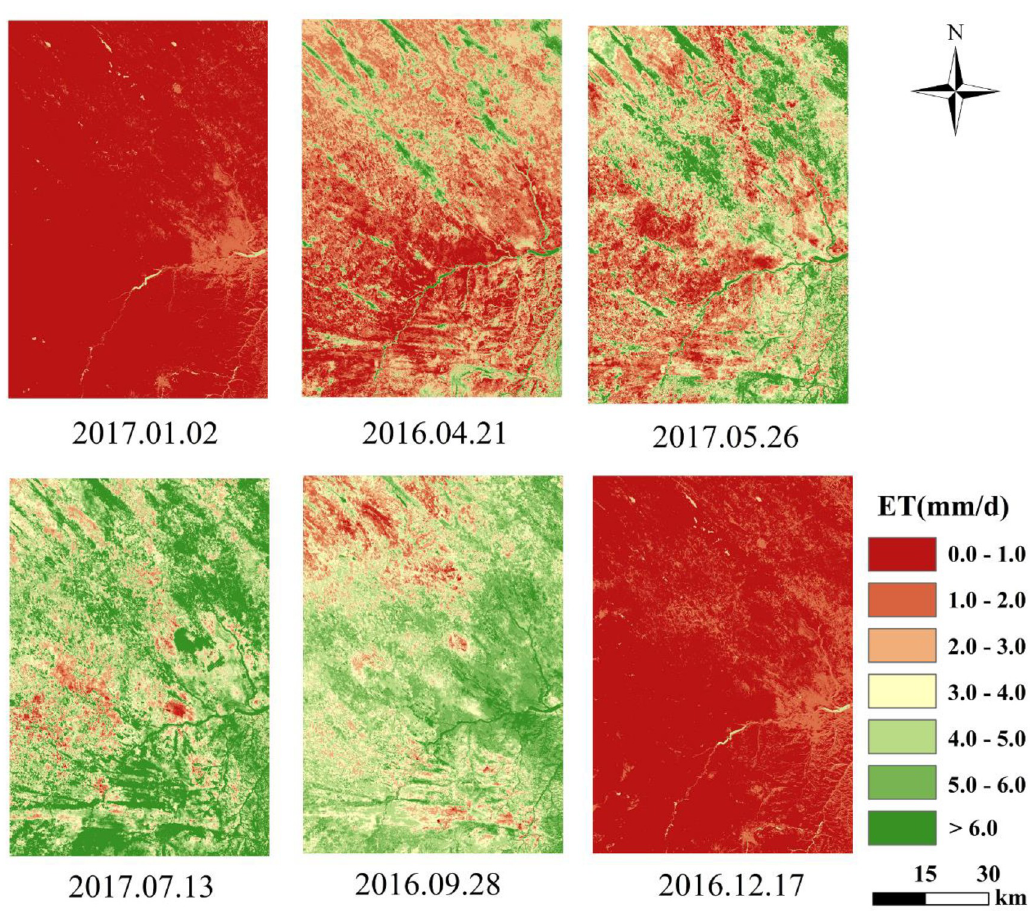
Fig 3. Spatiotemporal distribution of daily evapotranspiration in the agro-pastoral ecotone of northwest China.